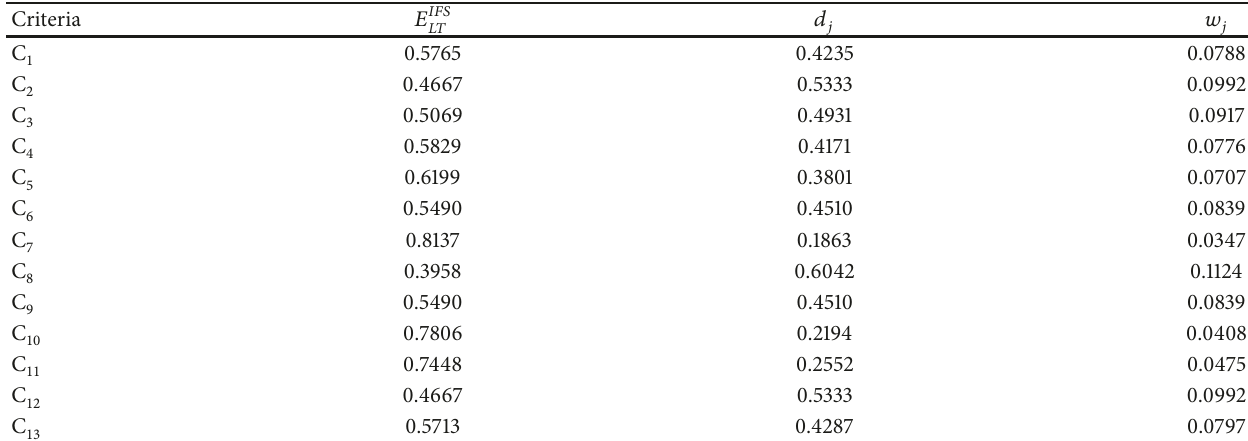
Table 8: Importance of the selection